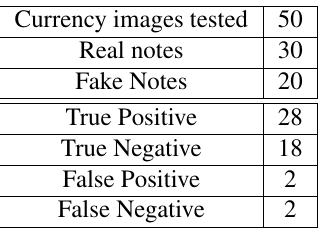
Table 4. Testing of